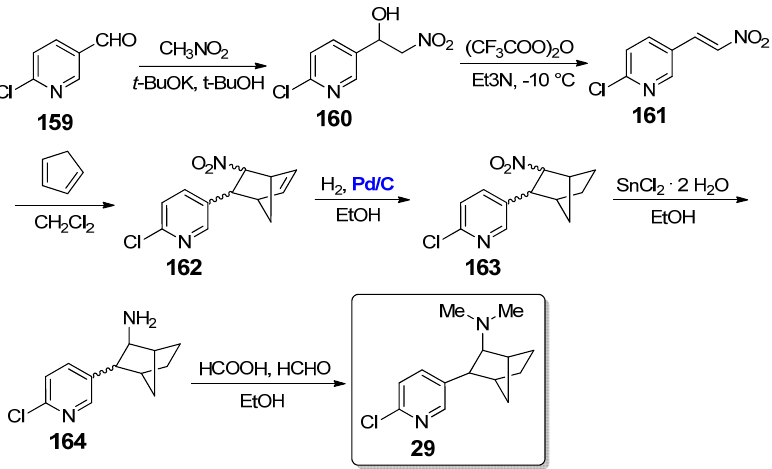
Scheme 28. Synthesis of conformationally restricted nicotine analogue 29 developed in 2019 by Manetti and co-workers [72]. The catalytic species involved in the synthetic pathway are indicated in